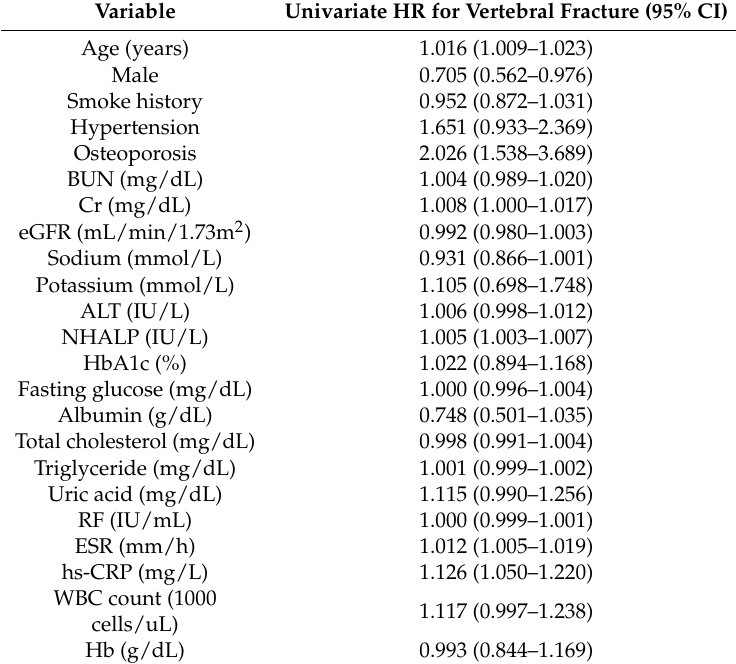
Table 3. Univariate analysis of risk factors associated with progression of vertebral fracture among 516 patients with rheumatoid